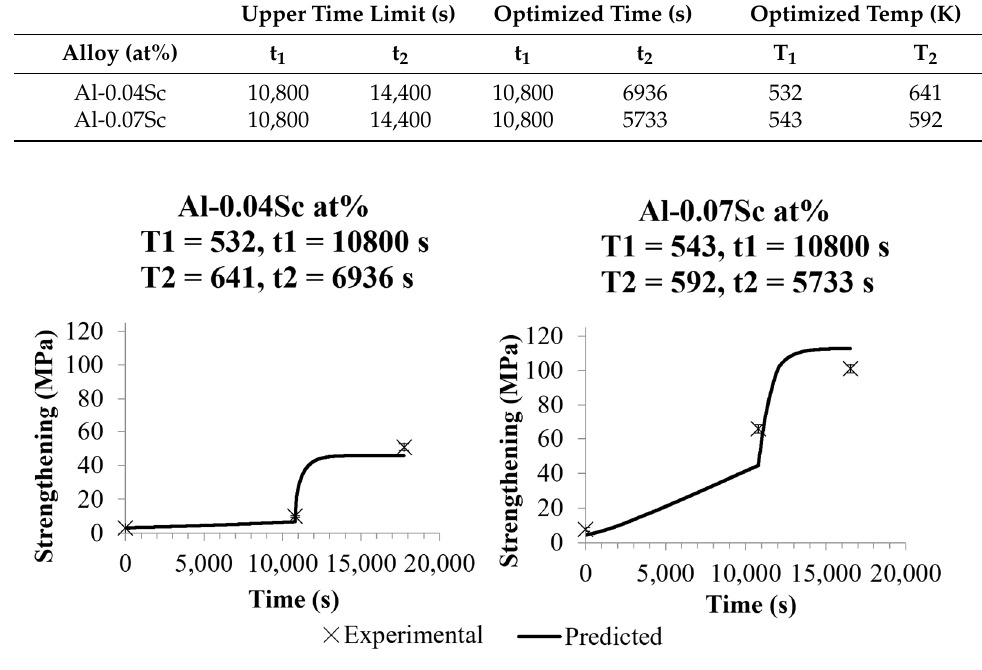
Figure 11. Graphs comparing the predicted and experimental results for heat treatments that were optimized to achieve the greatest strength in a restricted amount of time. In this case, t 1 and t 2 were limited to 3 h each. In both cases, optimal strengthening at T 2 occurred before 3 h. Error bars for experimental points represent +/ − 2 standard error.